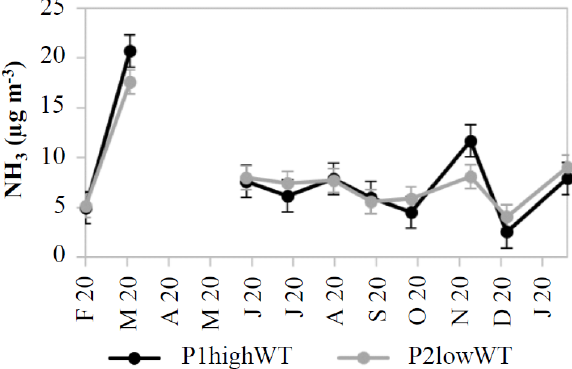
Figure 4. NH -N concentration in the ambient air. 3 Whiskers indicate standard error. Data for April laboratory closure.